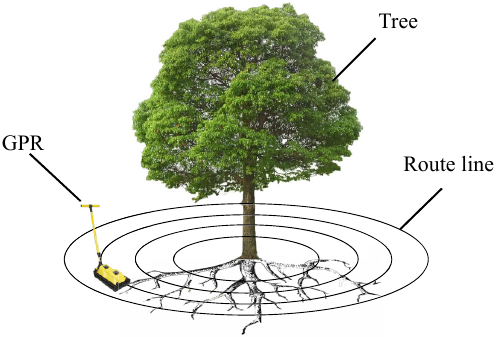
Figure 1. Detection method.